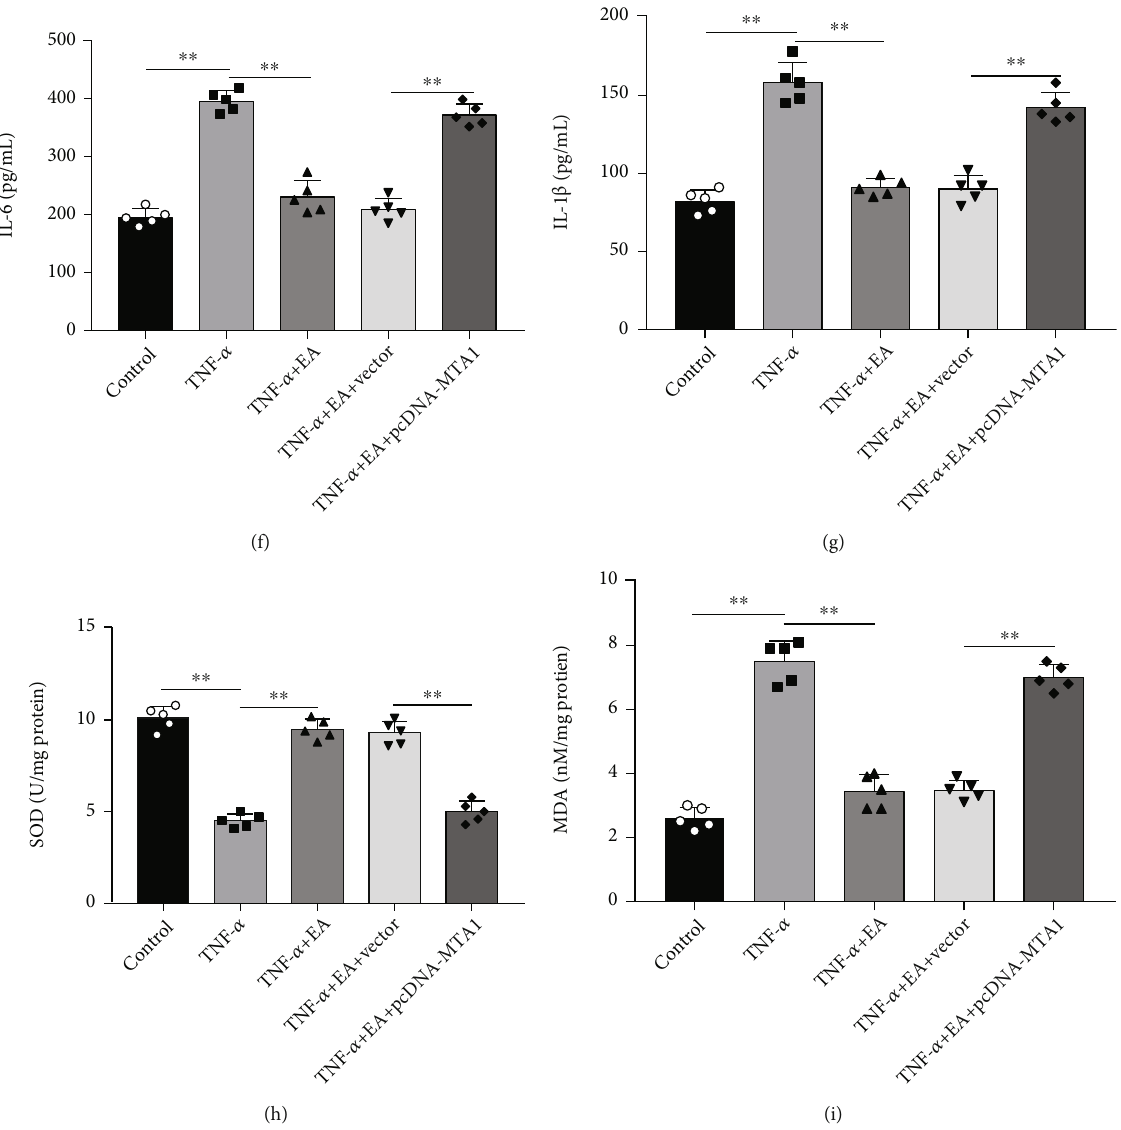
Figure 2: EA inhibited proliferation, in fl ammation, and oxidative stress and promoted apoptosis by downregulating MTA1 in MH7A cells. TNF- α -treated MH7A cells were treated with 50 μ M EA alone or together with pcDNA-MTA1. (a, b) The expression of MTA1 protein was detected by Western blot analysis. (c) CCK-8 assay was performed to measure MH7A cell proliferation. (d, e) MH7A cell apoptosis was measured by fl ow cytometry. (f, g) The levels of IL-6 and IL-1 β in cell culture supernatant were detected by ELISA. (h, i) The levels of SOD and MDA in MH7A cells were examined by commercial kits. Data from at least three replicate experiments were presented as mean ± SD . N = 5 . ∗∗ P < 0 : 01